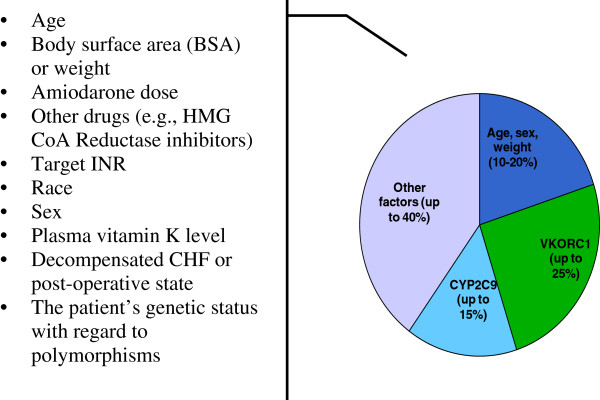
Factors that correlate withwarfarin dose. A number of factors affect warfarin dosing, including nongenetic factors (drug-drug interactions, environmental factors, diet, alcohol consumption, and smoking) and genetic factors. Genetic factors explain about 40% of warfarin dosing variability (adapted from
[16]).